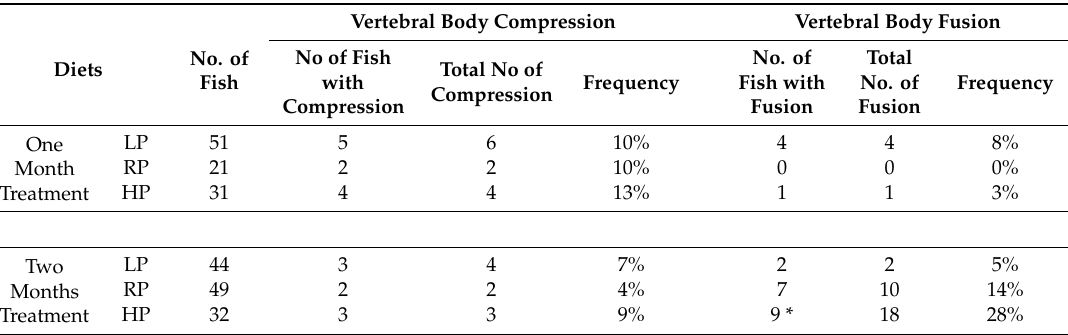
Table 2. Diagnosed vertebral body